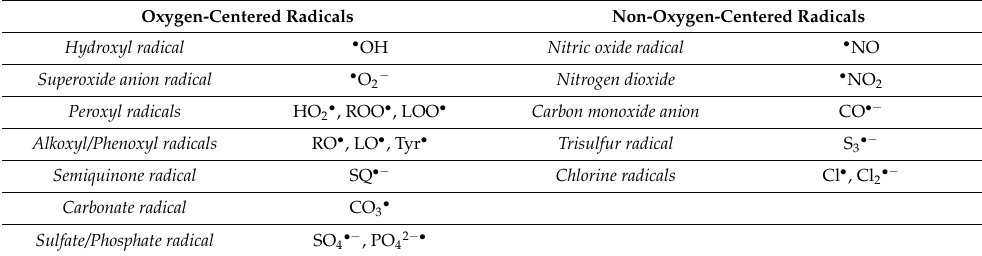
Table 1. List of common free